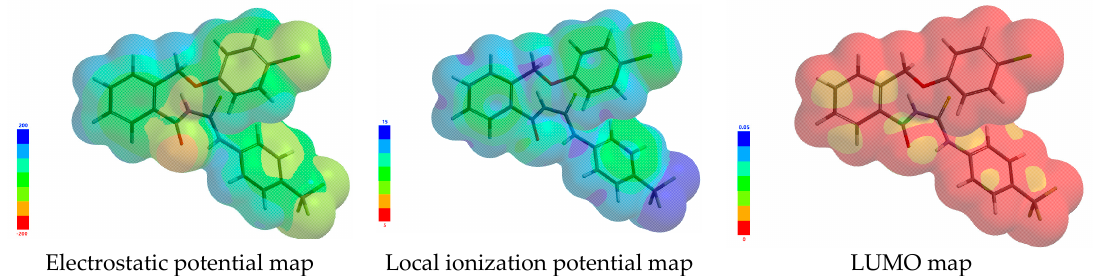
Figure 4. The most commonly-used graphical models, for 1g compound.